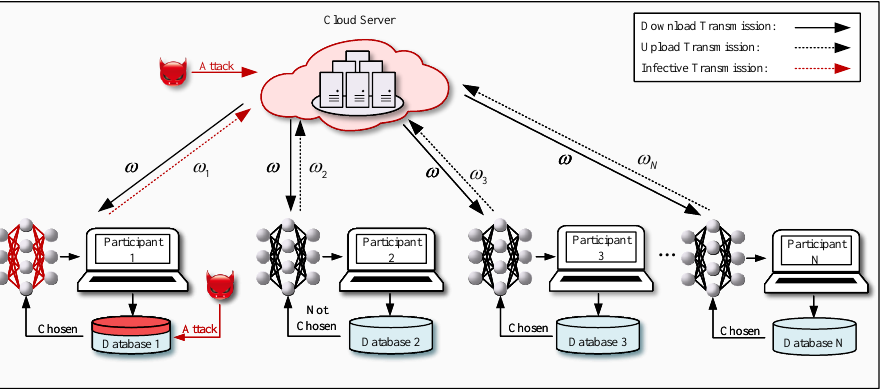
Figure 1. A system architecture for the multi-party learning training model with an honest-but- curious server or